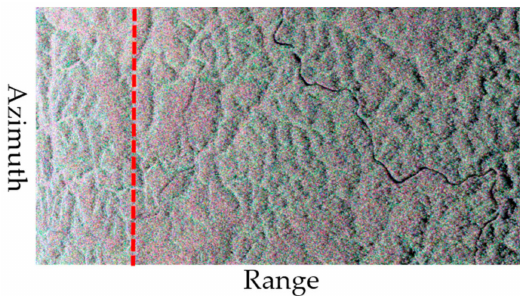
Figure 6. The selected azimuth profile (red dotted line) in the Pauli SAR image.